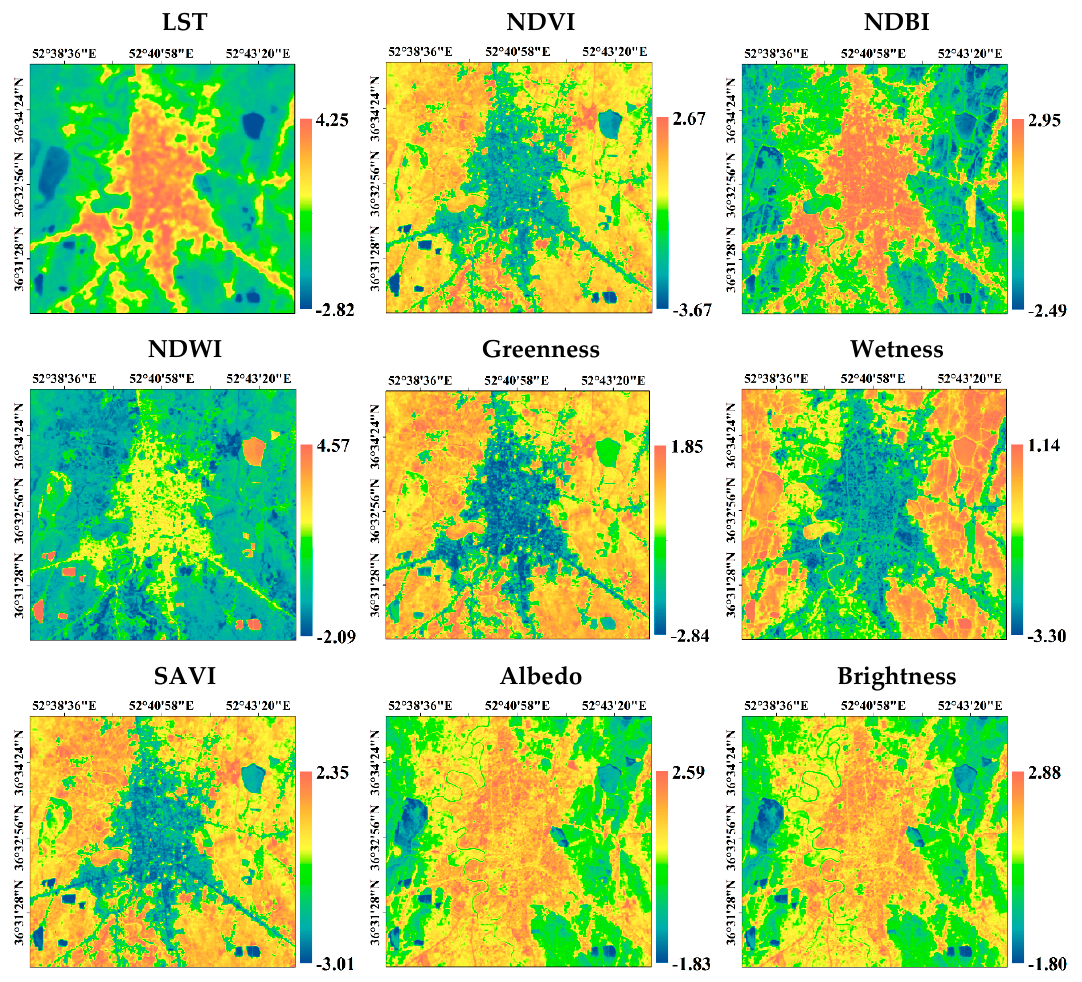
Figure 8. PC1 maps of LST and various surface biophysical parameters.